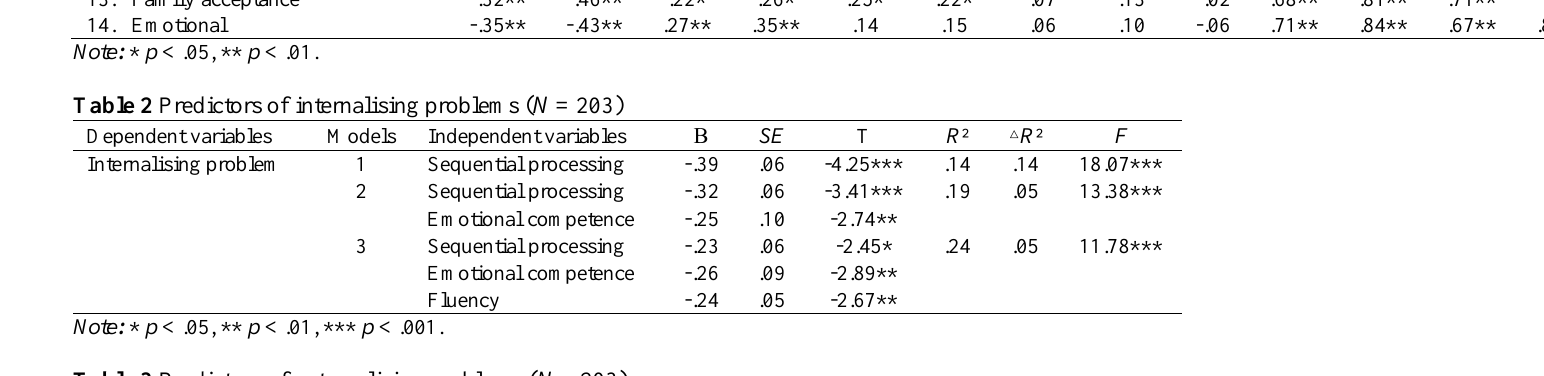
Table 3 Predictors of externalising problems ( N = 203) Dependent